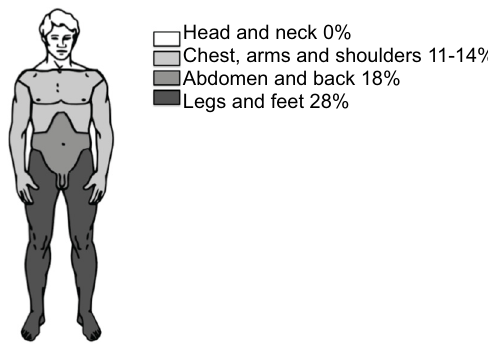
Figure 1. The distribution of pain reported by homeless shelter